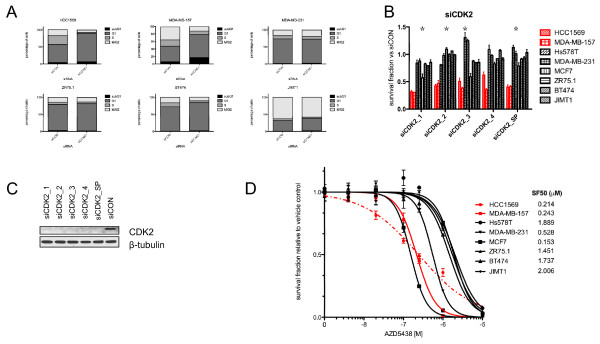
Cancer cells harbouring CCNE1 gene amplification show increased sensitivity to CDK2 silencing and chemical inhibition. (A) The fraction of cells in each phase of the cell cycle are shown following transfection with CCNE1 short interfering RNA (siRNA) and control (siCON) in cell lines with (HCC1569 and MDA-MB-157) and without (MDA-MB-231, ZR75.1, BT474 and JIMT1) CCNE1 amplification. (B) Bar plots illustrating the survival fraction of cells following transfection with CDK2 siRNA using individual duplex oligonucelotides (1 to 4) and a SMARTpool (SP) in cancer cells harbouring (red) or lacking (black) 19q12 amplification. Error bars represent the standard error of the mean of three replicates. Survival fractions are shown relative to those of siCON transfected cells. (* depicts significant t-test P values for the comparison of the survival fraction between cells with and without amplification of the target gene for an individual oligonucleotide). (C) Effects on CDK2 protein expression of CDK2 siRNA silencing with Dharmacon individual oligonucelotides and SMARTpool (SP) in MDA-MB-157 cells. (D) Dose response curves of breast cancer cell lines with (red) or without (black) 19q12 amplification to the CDK1, CDK2, and CDK9 inhibitor ADZ5438.